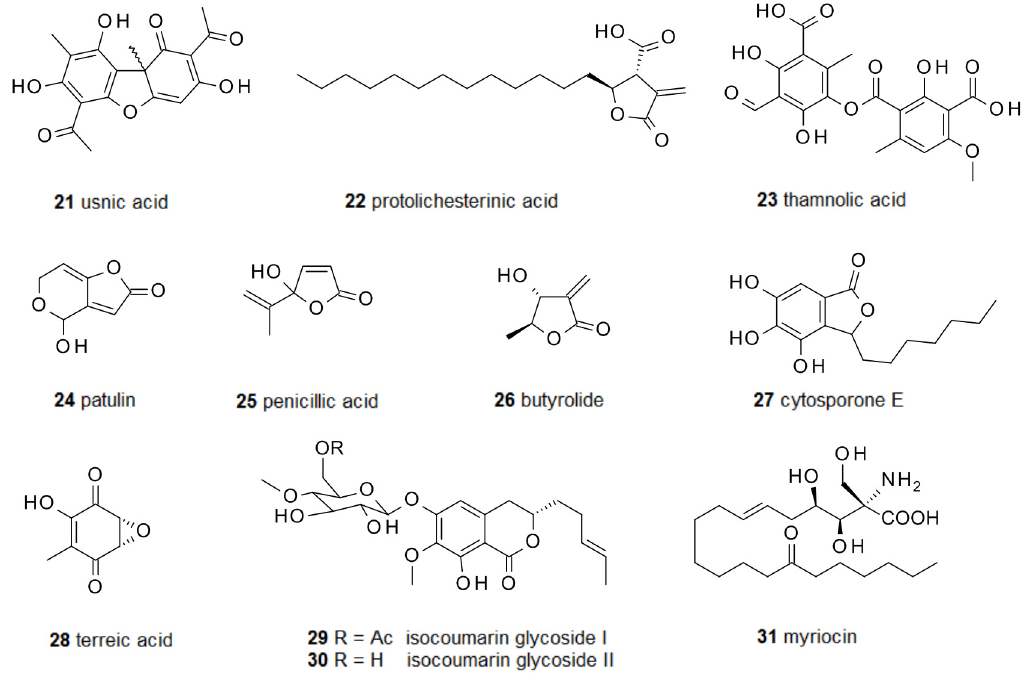
Figure 3. Biofilm-controlling metabolites from fungi synthesized via a polyketide biosynthetic pathway.